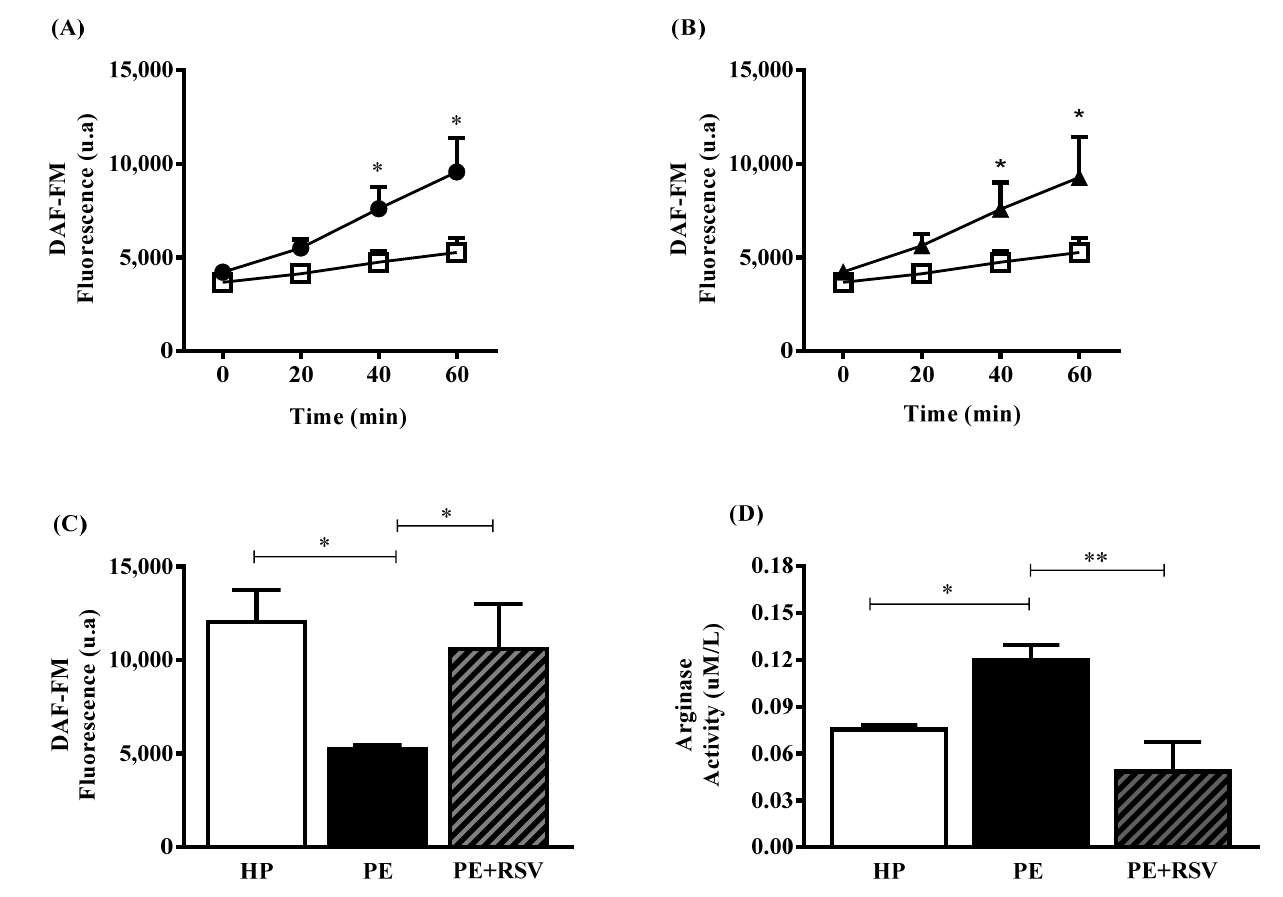
Figure 1. NO fluorescence intensity was measured by DAF-FM for 60 min ( A – C ) and arginase activity was quantified according to urea produced ( D ). Human umbilical vein endothelial cells (HUVECs) were incubated with 10% ( v / v ) pooled plasma from HP ( n = 10) and PE ( n = 10) ( A ) PE group was incubated with RSV (10 µ M) for 24 h ( B ) at 60 min of incubation with RSV are shown in ( C ) and arginase activity is demonstrated in ( D ). Data are presented as mean ± SEM. Comparisons between groups by DAF-FM were assessed by two-way ANOVA followed by Bonferroni’s Multiple Comparison Test (A–C) and one-way ANOVA (D) followed by Tukey’s test. * ( p < 0.05); ** ( p < 0.001). ● = HP; □ = PE; ▲ = PE + RSV.